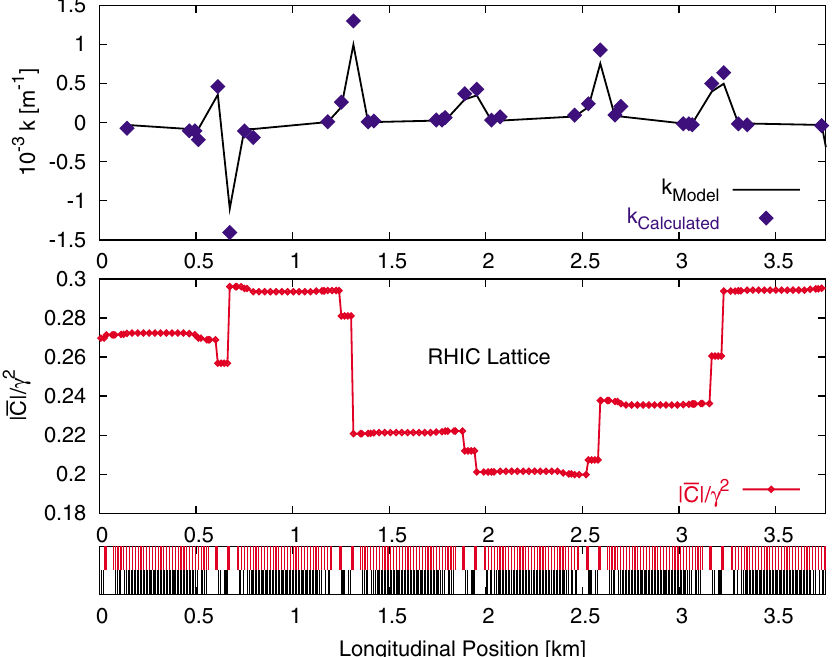
FIG. 8. (Color) Top: Skew quadrupole strengths calculated from RDTs and C matrix are compared to MAD-X model values. Note that RDTs are calculated from C matrix using Eqs. (9) and (10). Middle: j C j =(cid:20) 2 is plotted as a function longitudinal position. A representation of the lattice (dipoles in black and quadrupoles in red) is shown in the bottom graph. The horizontal and vertical tunes (cid:3) 28 : 266 and Q (cid:3) 29 : 212 , respectively, and (cid:3) Q (cid:3) 4 : 37 (cid:1) 10 (cid:2) 2 are Q x y min